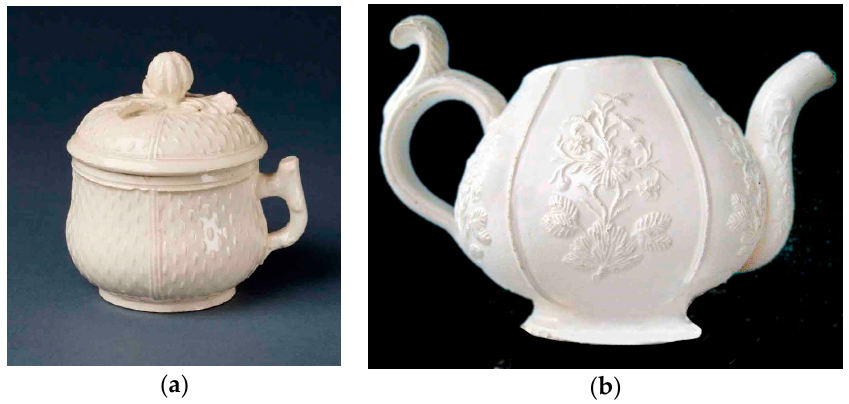
Figure 3. French white earthenware . ( a ) Gravy (meat juice) pot with cover. Molded decoration with rice grain or barley corn patterns. Attributed to the Pont-aux-Choux pottery factory, ca. 1760–1780. Reg. No. C.127&A-1945. © Victoria and Albert Museum, London. ( b ) Teapot attributed to Lunéville. Molded decoration with flowers. Terre de pipe . Late 18th century. H: 12 cm. © M. Maggetti, Private collection. [16] (An. No. TBL 1).